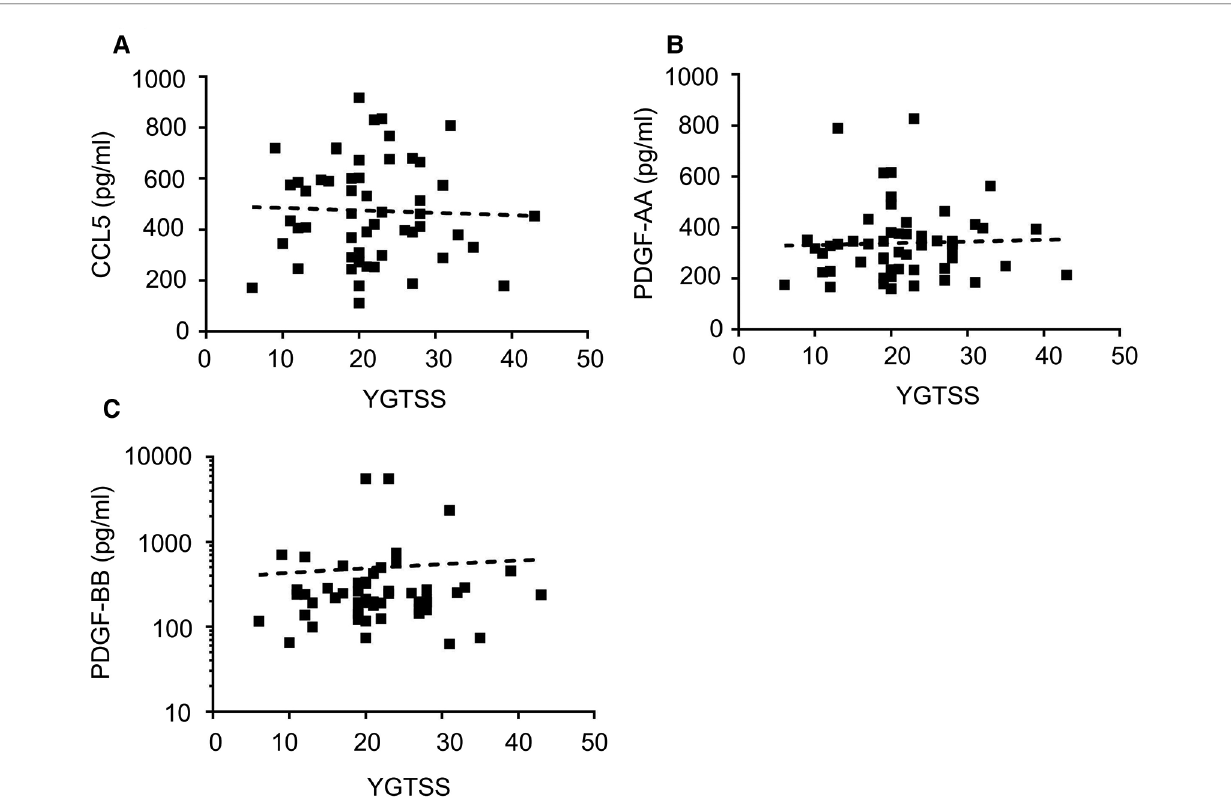
FIGURE 4 The correlations of the levels of plasma CCL5, PDGF-AA, PDGF-BB with tic severity of all TD patients. The correlations of the levels of plasma CCL5 ( A ), PDGF-AA ( B ), PDGF-BB ( C ) with tic severity of all TD patients assessed with the YGTSS.